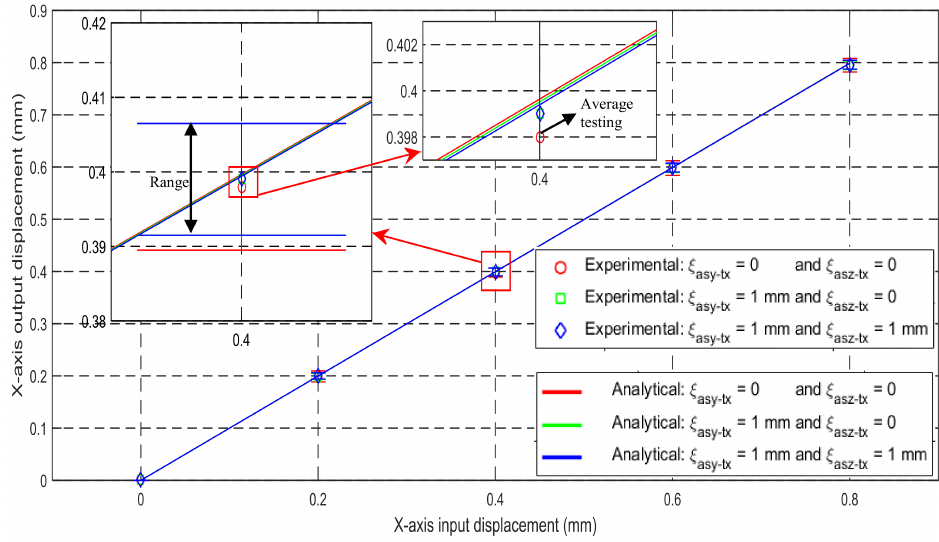
Figure 16. Relationship between the input displacement and the output displacement along the X ms